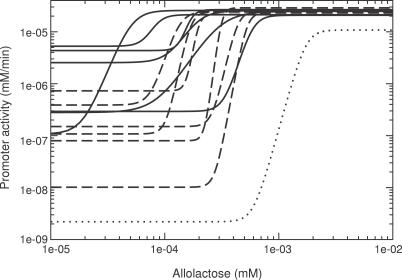
Promoter Functions at Zero Glucose, Evolution in a Well-Mixed EnvironmentDotted line, initial promoter function. Solid lines, promoter functions of the six last common ancestors of the stochastic evolutionary simulations. Dashed lines, promoter functions of the six last common ancestors of the deterministic evolutionary simulations.